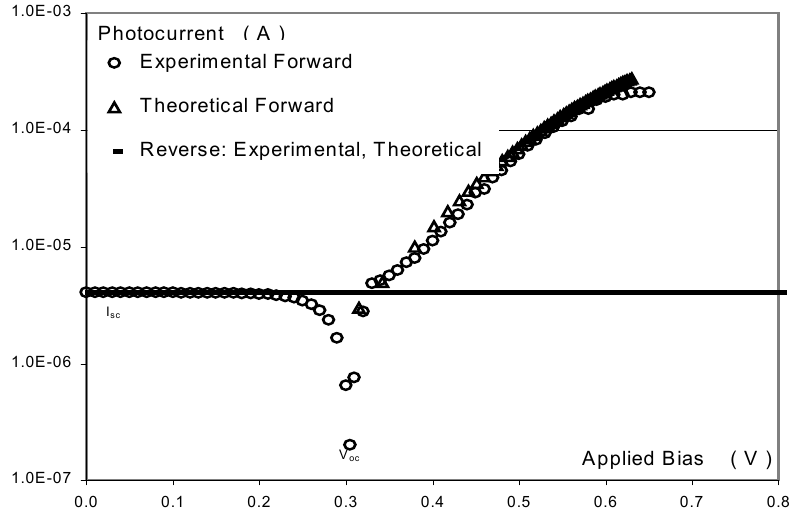
Figure 4. The experimentally obtained photocurrent under illumination level L